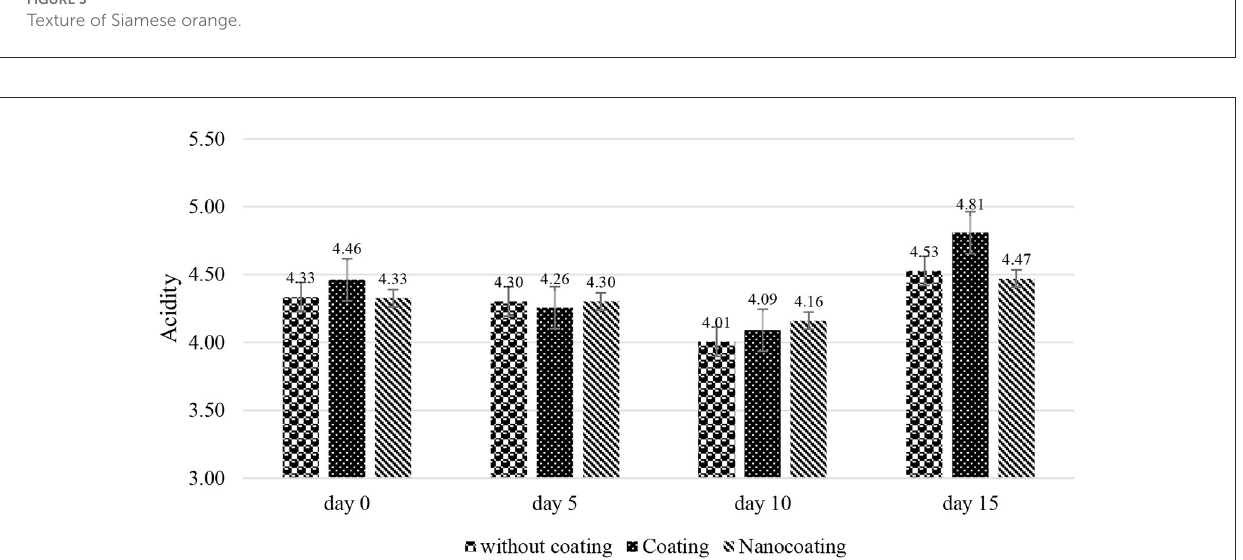
FIGURE4 Acidity of Siamese